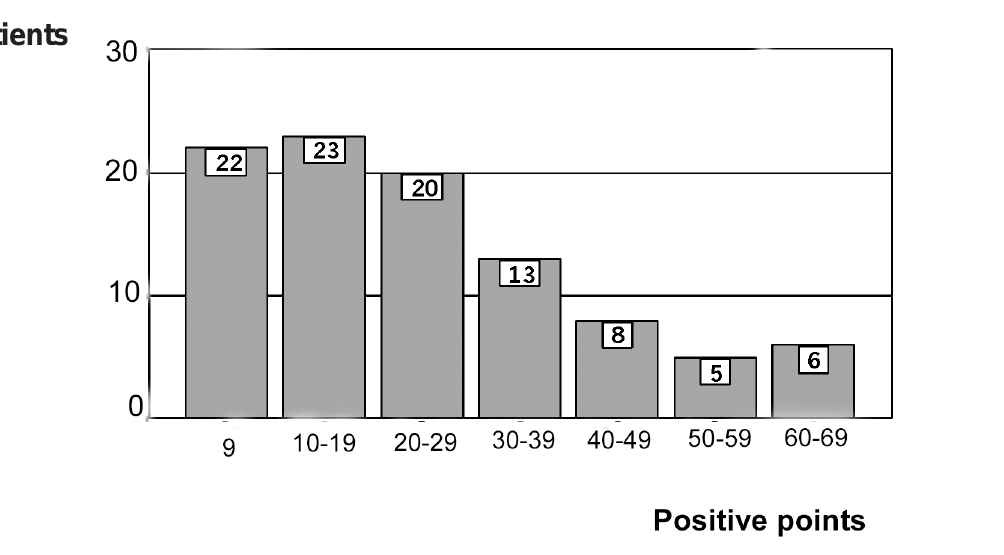
Figure 5 – Distribution of positive points up to a value of 69 in 97 patients submitted to radical